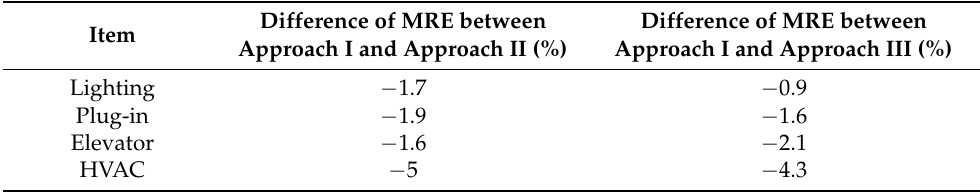
Table 6. Comparison of the MREs of testing results of the NIM models between Approach I and